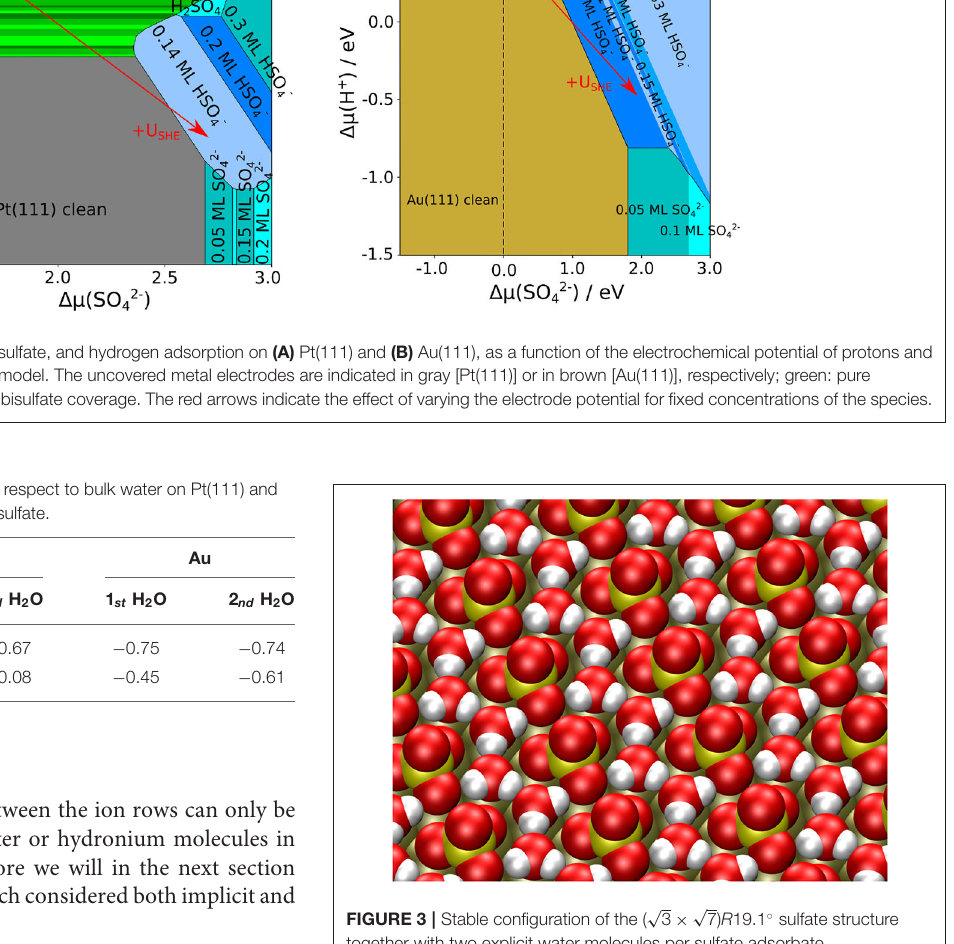
FIGURE 3 | Stable configuration of the ( √ 3 together with two explicit water molecules per sulfate